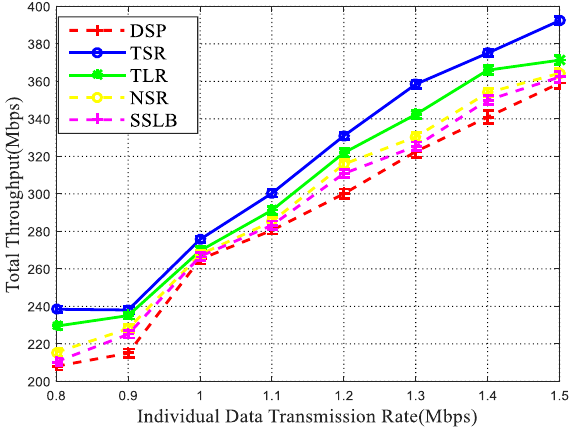
Figure 9. Packet drop rate vs. data transmission rate.